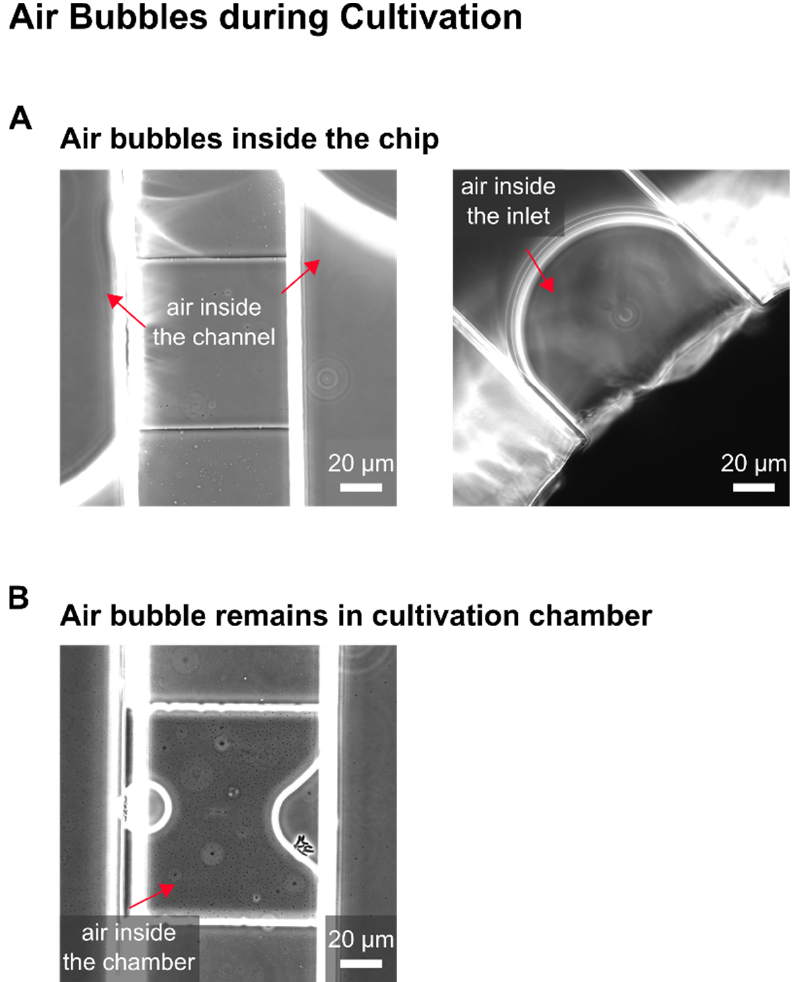
Figure A4. Example images of air bubbles during cultivation (see Table 5). Microscope images of ( A ) Air bubbles inside the chip and ( B ) air bubble remains in cultivation chamber.